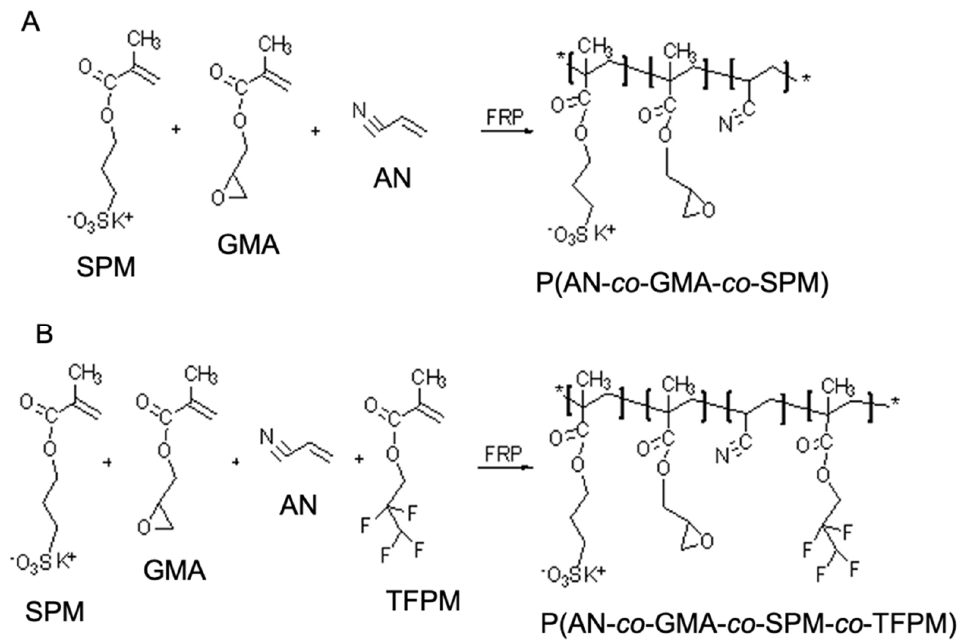
Figure 1. Synthesis of random ionomers via free-radical solution polymerization: P(AN- co -GMA- co -SPM) ( A ) and P(AN- co -GMA- co -SPM- co -TFPM) ( B ).